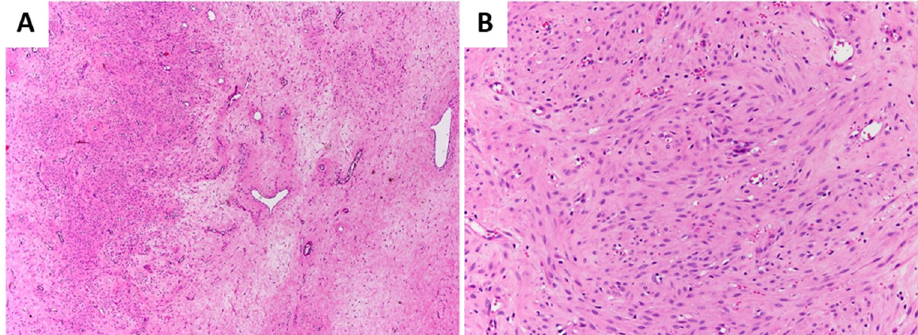
Figure 9. Primary DAM with leiomyomatous nodular differentiation . ( A ) In the context of an otherwise classic-type DAM, a vaguely nodular area composed of smooth muscle cells with focal fascicular arrangement is observed; ( B ) notice the morphological details of the cells. This tumor was interpreted as a “classic-type DAM with nodular leiomyomatous differentiation”; (vii) in one case, tumor stroma was predominantly (>90%) hypocellular and fibro-sclerotic in nature; the tumor showed numerous thick keloid-like collagen bands and blood vessels with hyalinized walls (Figure 10A–C); the tumor exhibited a fibro- lipomatous appearance at the periphery (Figure